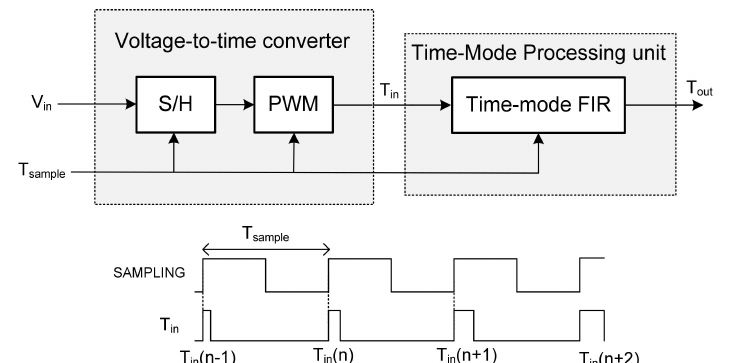
Figure 1. Block diagram of the voltage-to-time conversion followed by a time-mode processing